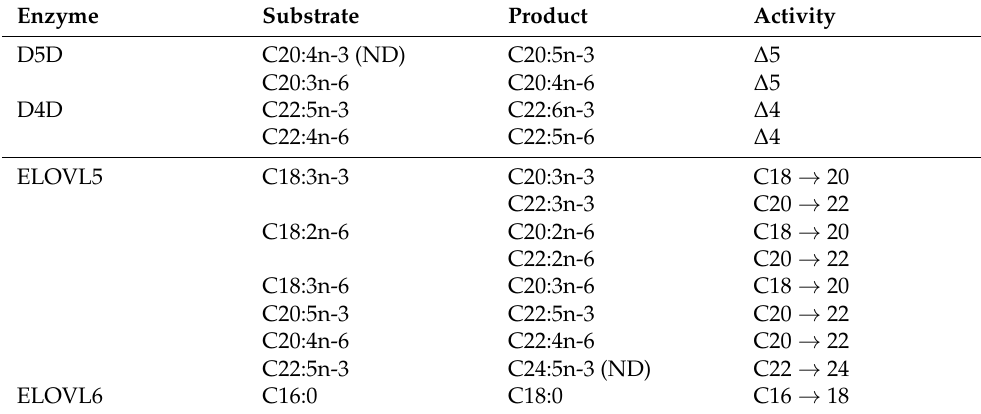
SCD: stearoyl-CoA desaturase, D4D: delta-4-desaturase, D5D: delta-5-desaturase, D6D: delta-6-desaturase, D8D: delta-8-desaturase, ELOVL5: elongase 5, ELOVL6: elongase 6, ND: non detected. More information in Supplementary Figure S2.